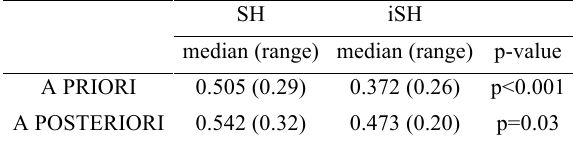
Table 2. Comparison of scanpath similarity of visual imagery and viewing in SH subjects with and without 5increased simu- lated visual field (iSH) demonstrates especially for the a priori analysis a highly significant difference between SH and iSH. SH median (range) median (range)